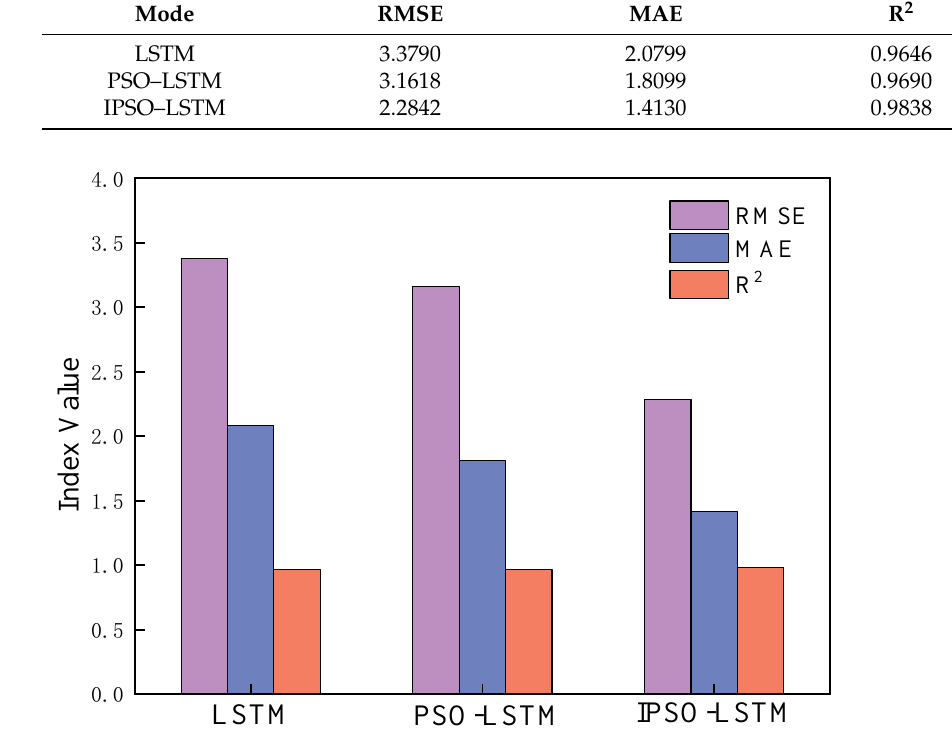
Figure 12. The chart of evaluation indexes of different models in a single fusion pattern.